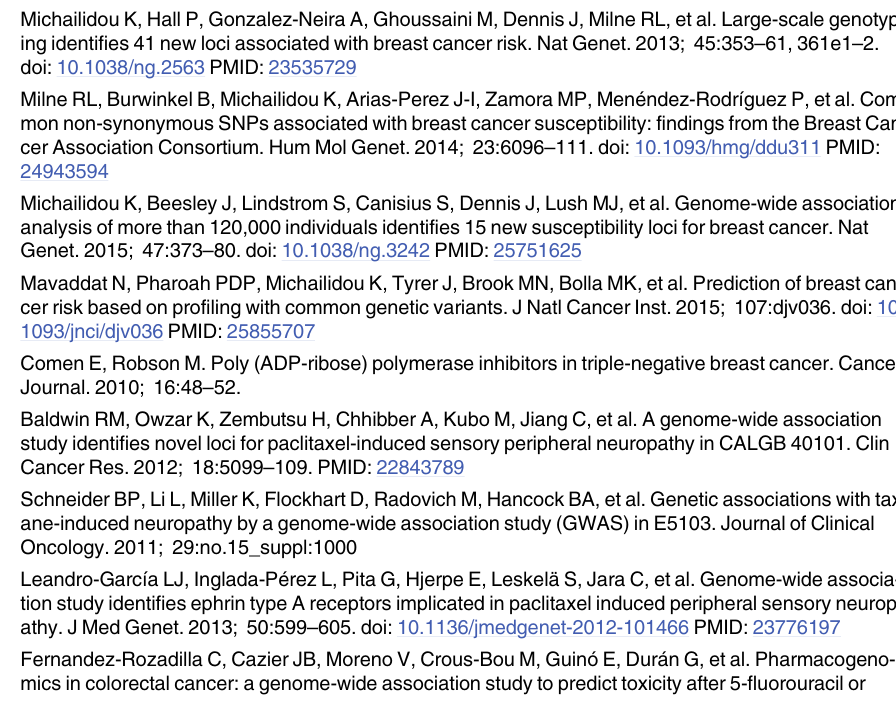
S1 Fig. Summary of PGSNPS clinical trials regimens. S1 Table. Summary of Clinical Trials contributing to PGSNPS. S2 Table. Patient